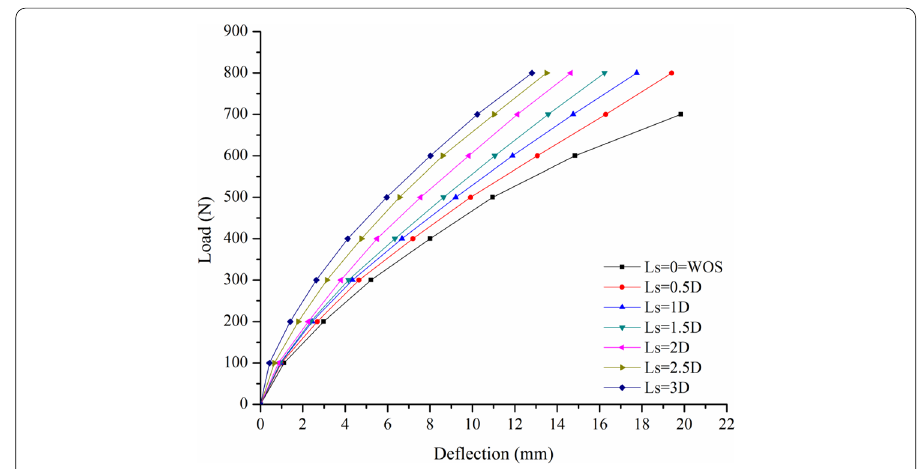
Fig. 4 Lateral load defection behavoiur of 50.8 mm diameter pile with embedded depth of 1000 mm (L